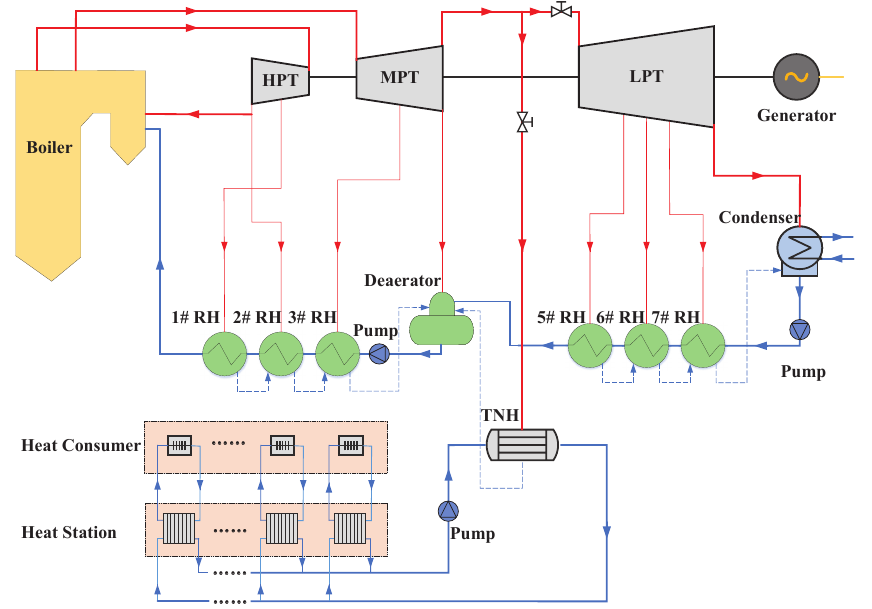
Figure 1. Schematic of the traditional coal-fired CHP-EC